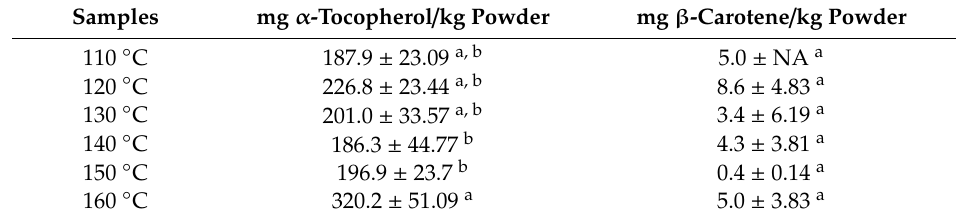
Table 3. Total α -tocopherol and β -carotene content of spray dried AWW without the addition of